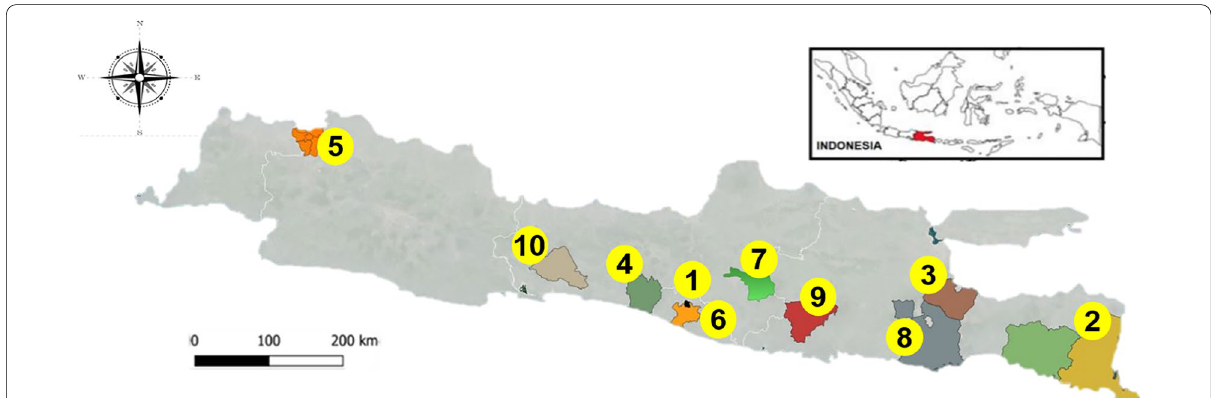
Fig. 1 Map of banana cultivars locality from Jawa Island. 1. Yogyakarta, 2. Banyuwangi, 3. Pasuruan, 4. Purworejo, 5. DKI Jakarta, 6. Bantul, 7. Karanganyar, 8. Malang, 9. Ponorogo, 10.